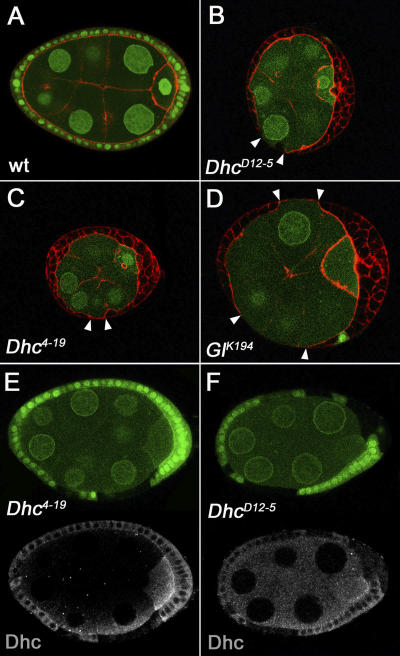
Cytoplasmic Dynein Function Is Required for Epithelial Cell Shape and Integrity(A–F) Wild-type cells are marked with green fluorescent protein (GFP).(A–D) Phalloidin staining (red) reveals FC morphology.(A) Wild-type ECs are surrounded by a uniform monolayer of cuboidal FCs.(B and C) Loss of Dhc function in the FCs, through either the newly isolated D12–5 allele (B) or the previously characterized 4–19 allele (C), leads to disruptions of cell shape and gaps in the epithelium (arrowheads).(D) K194, a newly isolated allele of the Dynactin component Glued, phenocopies the loss of Dhc in the FCs.(E) Immunohistochemistry on mosaic egg chambers containing Dhc4
−19 mutant clones shows that Dhc protein levels (grayscale) are strongly reduced.(F) Dhc levels are similarly reduced in DhcD12
−5 mutant clones.